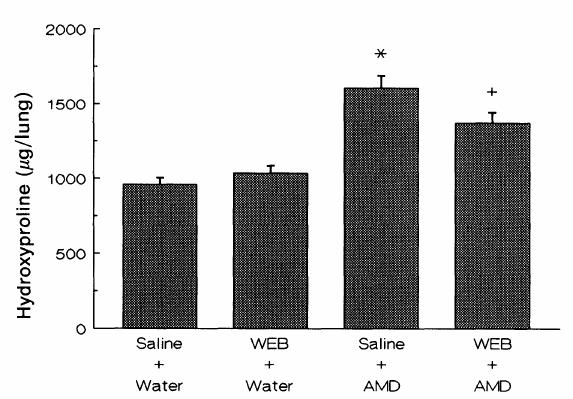
FIG. 2. Effects of WEB 2086 on amiodarone (AMD) induced increases in hydroxyproline content of hamster lungs. See the legend to Fig. for treatment details. Each value represents the mean ___S.E.M. of eight animals in each group. Significantly higher (p < 0.05) than all other groups, Significantly higher (p < 0.05) than saline + water and WEB -t- water groups. Mediators of Inflammation-Vol 2.1993